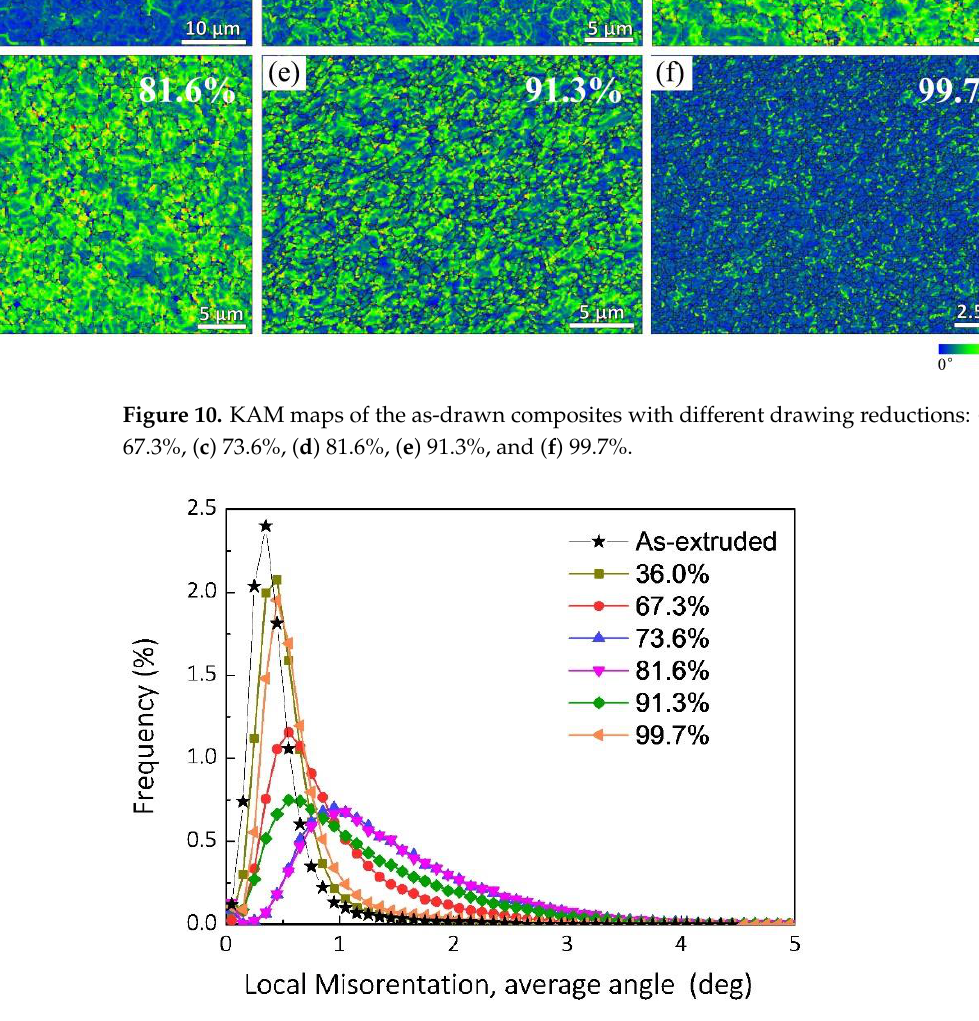
Figure 11. KAM values of the composites with different deformation reductions.